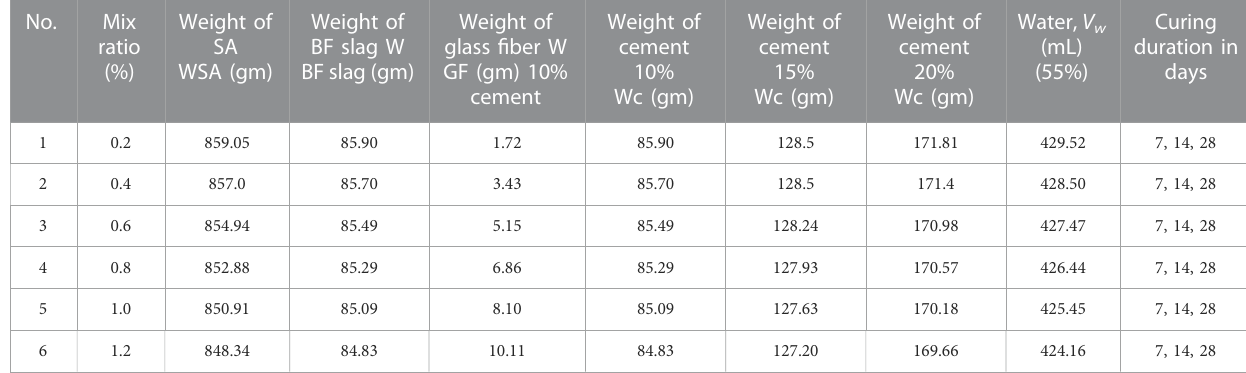
TABLE 1 Mix ratios and quantity of materials used for preparing cube and beam specimens.